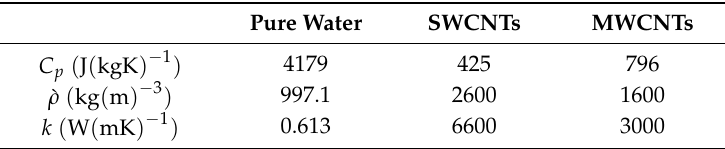
Table 1. Physical and thermal properties of pure water and CNTs [11,27]. CNTs: carbon